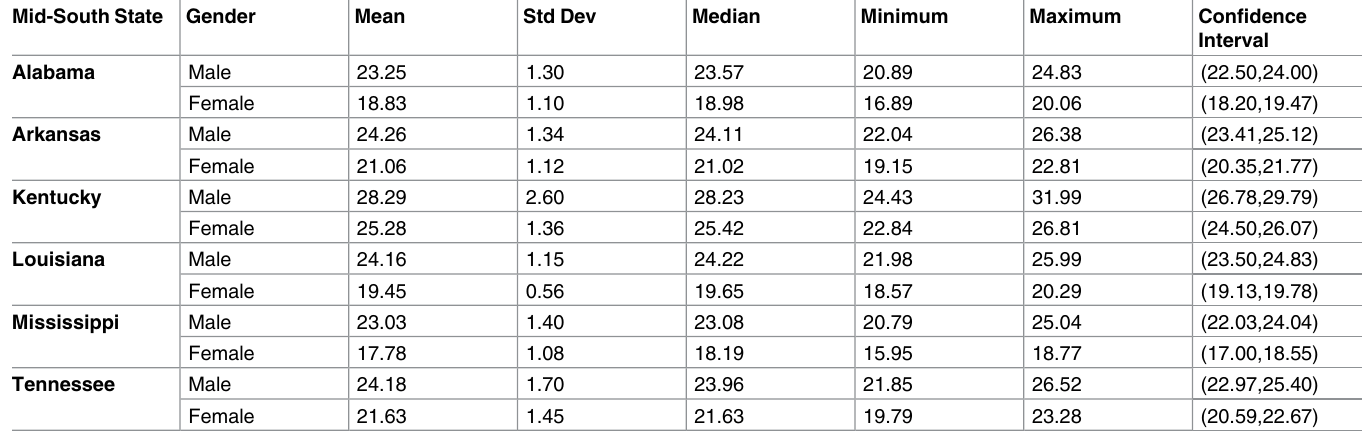
Table 11. Summary statistics for mean percent of daily smokers in the Mid-South states, 1999–2012.